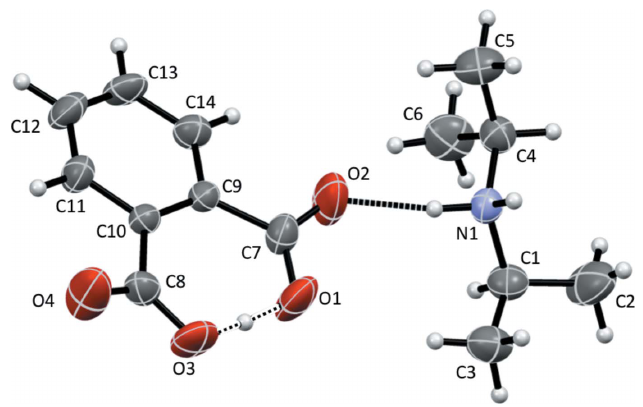
Figure 1 View of the title compound showing the atom-labelling scheme. Anisotropic displacement parameters of non-H atoms are drawn at the 50% probability